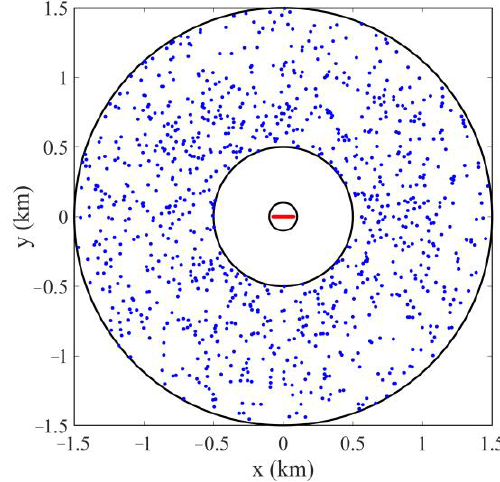
Figure 1. Observation system of synthetic background noise.